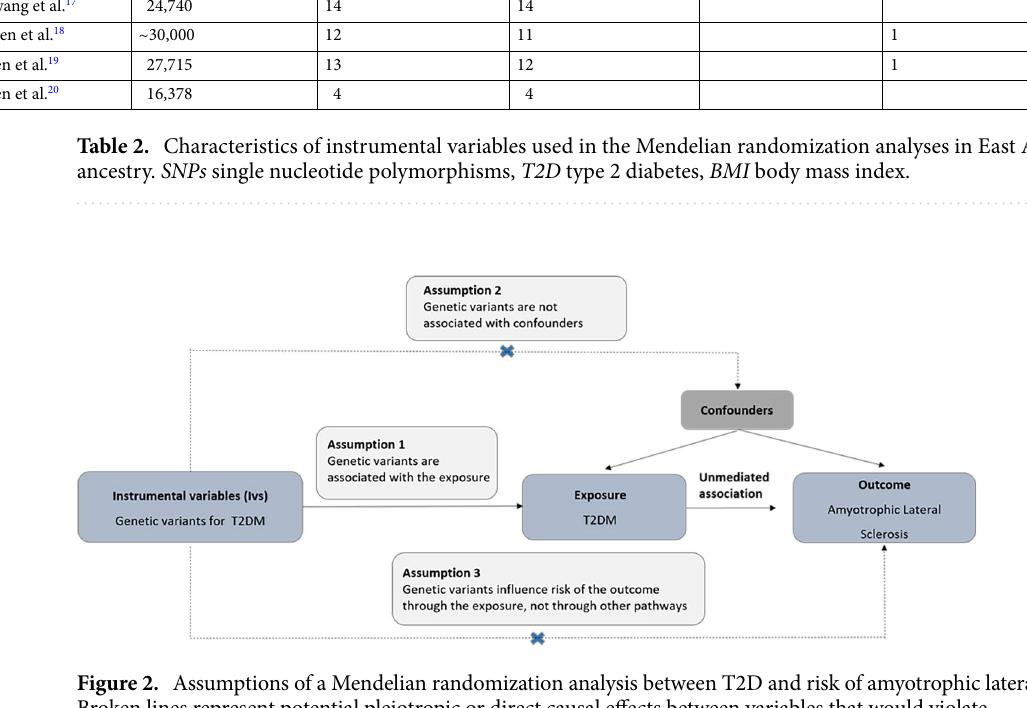
Figure 2. Assumptions of a Mendelian randomization analysis between T2D and risk of amyotrophic lateral. Broken lines represent potential pleiotropic or direct causal effects between variables that would violate Mendelian randomization assumptions. T2D type 2 diabetes